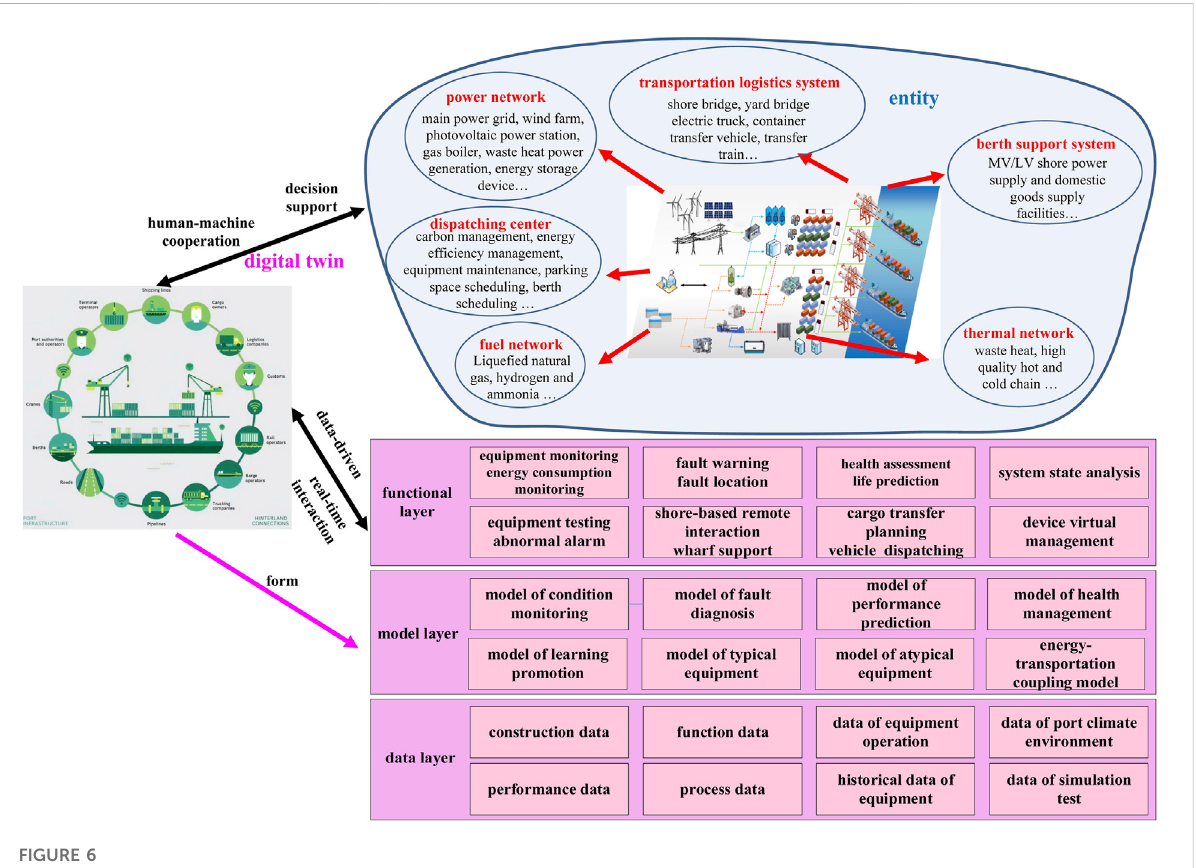
FIGURE 6 Equipment cluster management and decision of